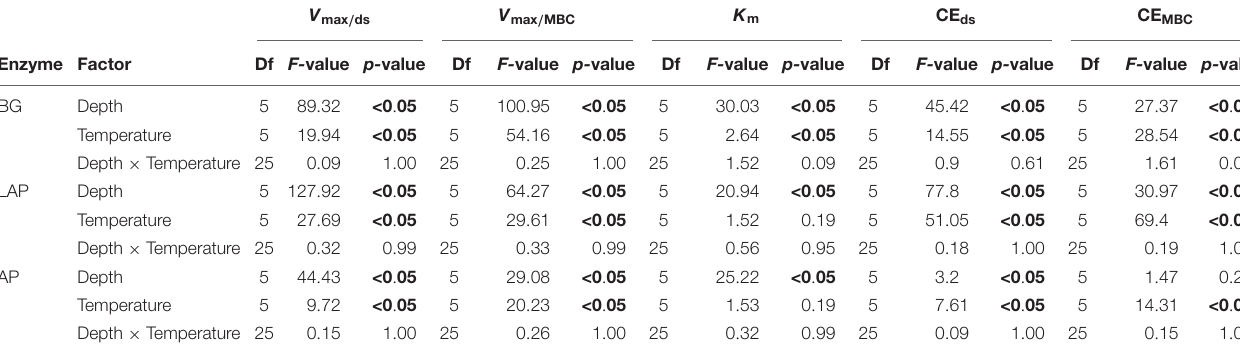
FIGURE 1 | Enzyme maximum velocity ( V max ) at different depths and six temperatures from 4 to 50 ◦ C, expressed per (A) dry soil mass ( V max / ds ), or (B) microbial biomass C ( V max / MBC ). Two-way ANOVA with depth and temperature as interactive factors indicated that both depth and temperature had a significant effect on V max of all enzymes ( p < 0.05), but without interaction between the two factors ( Table 3 ). Colors indicate incubation temperatures and letters indicate significant differences ( p < 0.05) between depths per enzyme, based on Tukey’s tests after ANOVA tests. Error bars represent the standard error of the mean ( n = 3). TABLE 3 | Two-way fixed effects ANOVA of kinetic parameters with depth and temperature as independent factors, per